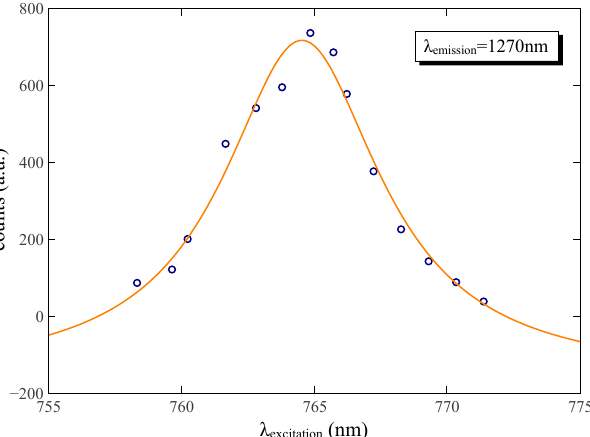
Figure 5. Blue dots are the spectrum of the Rb-Ne crystal, observing the light output at λ emission = 1270 nm as a function of the excitation wavelength. The orange curve is the Lorentzian L ( λ ) fit of the